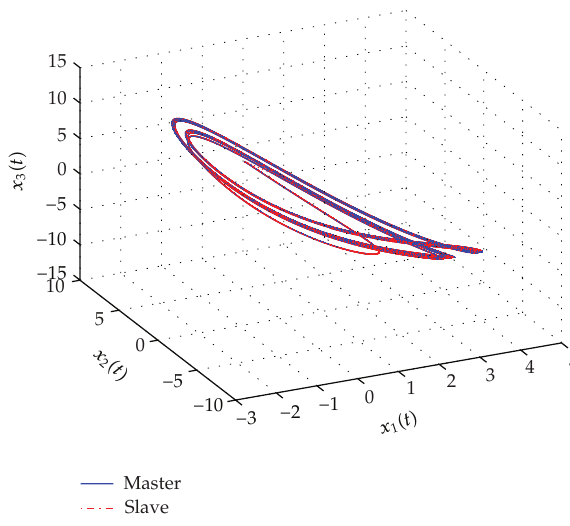
Figure 6: The chaotic behaviors of the master and slave systems.